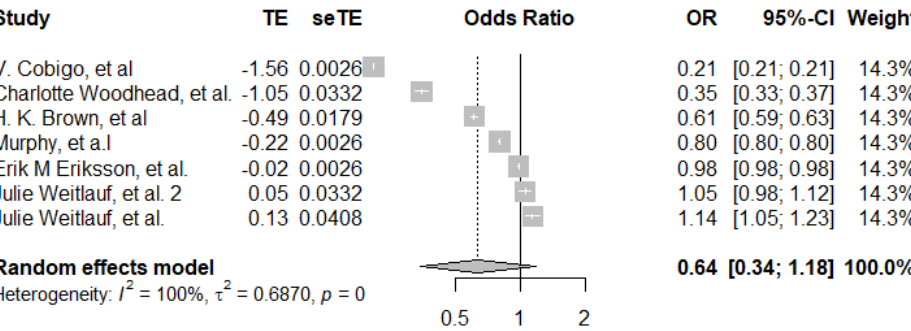
Figure 5. Pooled adjusted odds ratio estimates of breast cancer screening uptake by psychosocial disability status [26–28,33–36].